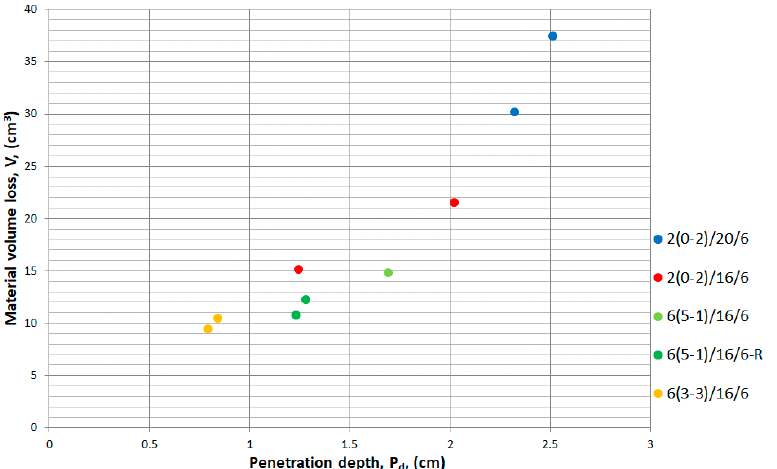
Figure 12. Correlation between material volume loss, V and penetration depth, P d.